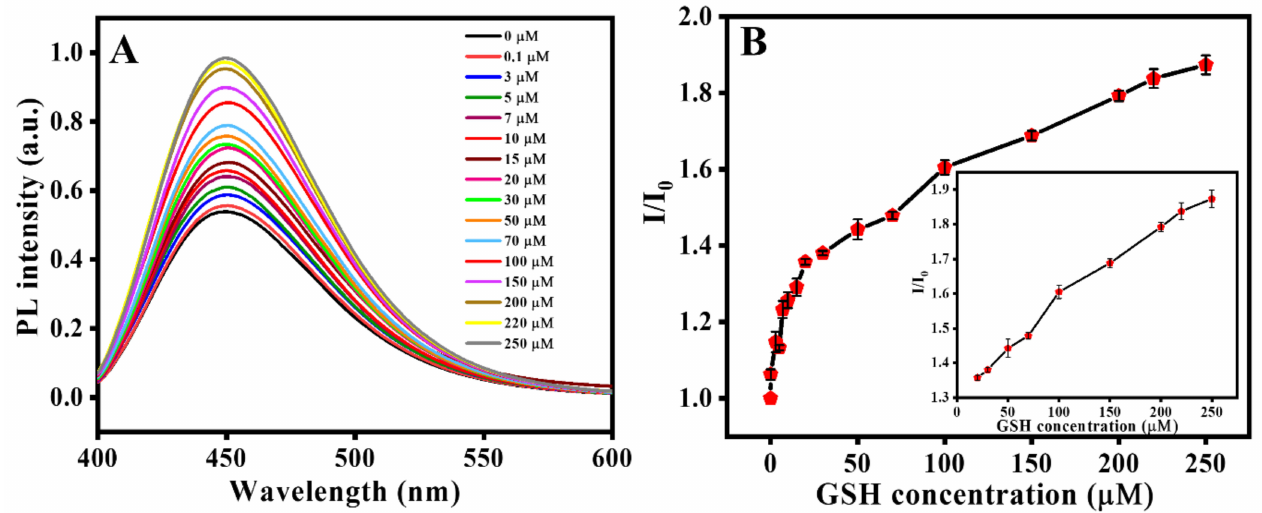
Figure 8. ( A ) Fluorescent spectra and ( B ) relative fluorescent intensity of the NPCD-MnO 2 composite in the existence of different levels of GSH (inset: linear correlation between I / I 0 and GSH level from 20 µ M to 250 µ M).